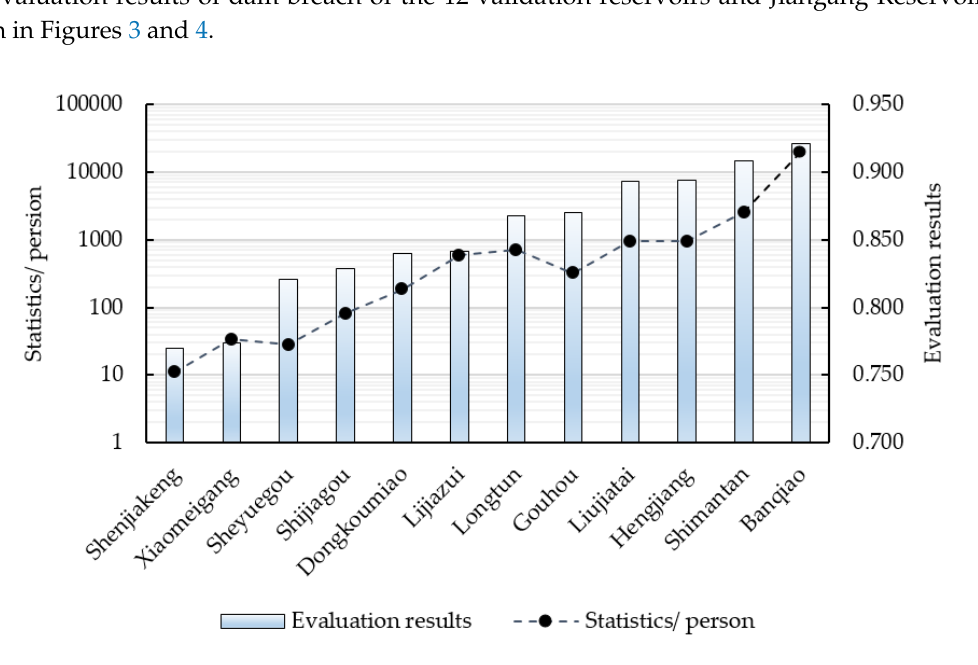
Figure 3. Evaluation results of dam breach of the validation reservoirs. ** Loss of life is plotted on a logarithmic scale.